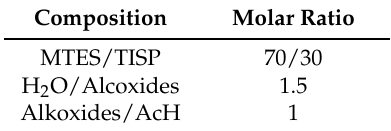
Table 1. Composition of the 70MTES/30TISP sol.